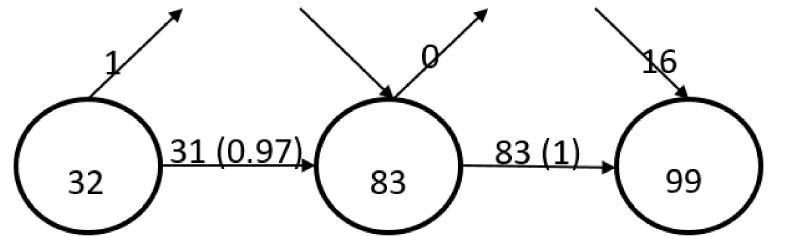
Figure 5. Overlapping map of the sample.